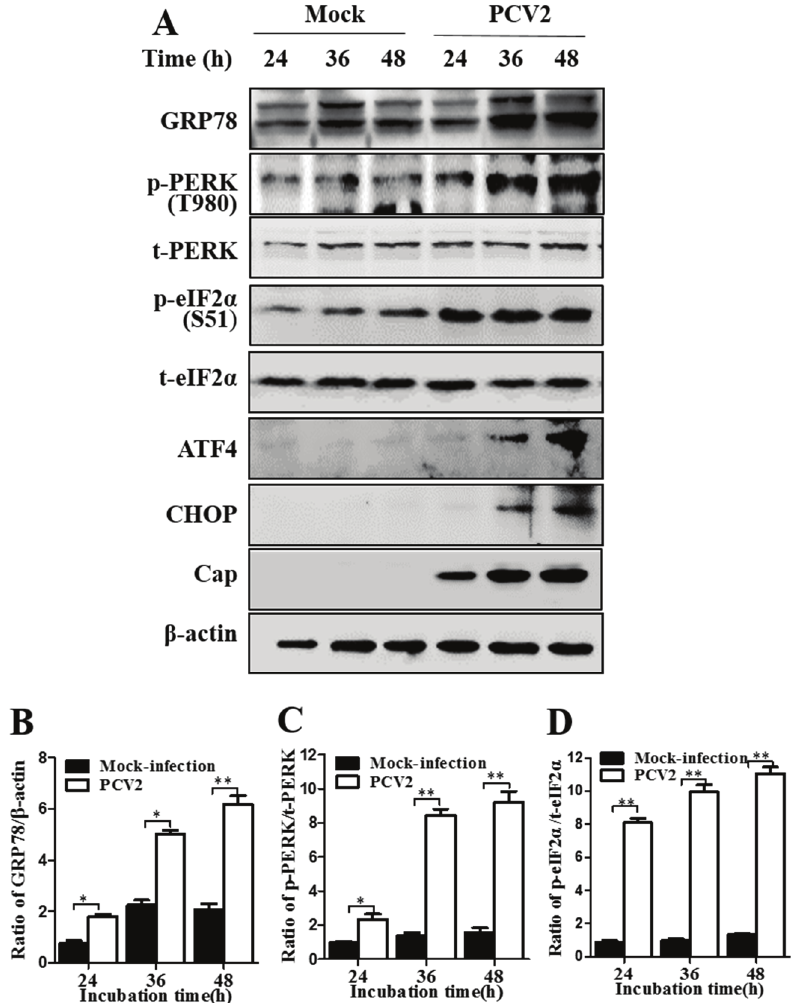
Figure 2. Porcine circovirus 2 infection induced unfolded protein response and expression of the pro-apoptotic protein CHOP by activating the PERK/eIF2 α /ATF4/CHOP axis. PK-15 cells were infected with PCV2 or mock-infected for indicated time points. ( A ) Representative images of Western blotting for the target proteins; ( B – D ) Ratios of GRP78 to β -actin ( B ), phosphorylated PERK (p-PERK) to total PERK ( C ), and phosphorylated eIF2 α (p-eIF2 α ) to total eIF2 α (t-eIF2 α ) ( D ). Ratios of targeted proteins to β -actin or t-PERK/t-eIF2 α were normalized to mock infection set at 1.0. All data are reported as means ± the standard errors of the mean of three independent experiments (*, p < 0.05; **, p < 0.01) here and in all subsequent figures.